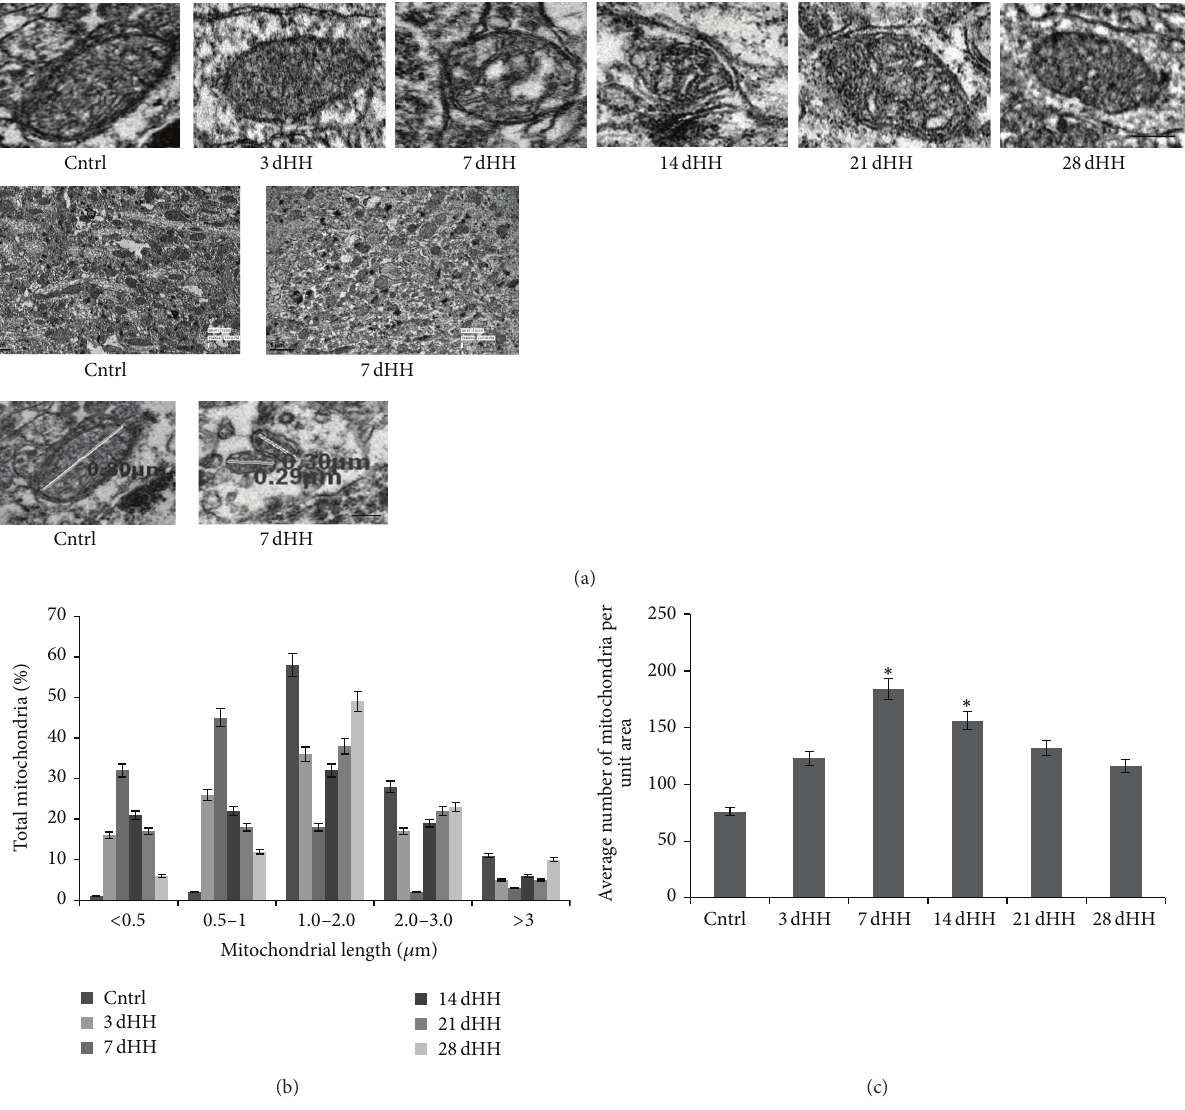
Figure 3: (a) Representative electron micrograph of hippocampal CA1 region shows temporal alteration in mitochondrial morphology and graphical representation showed changes in (b) mitochondrial length and (c) number. ∗ denotes 𝑝 < 0.05 compared to Cntrl. Data are expressed as mean ± SD; 𝑛 = 3 . Bar depicted in the figures is equivalent to 50 nm, 1 𝜇 m, and 100nm in